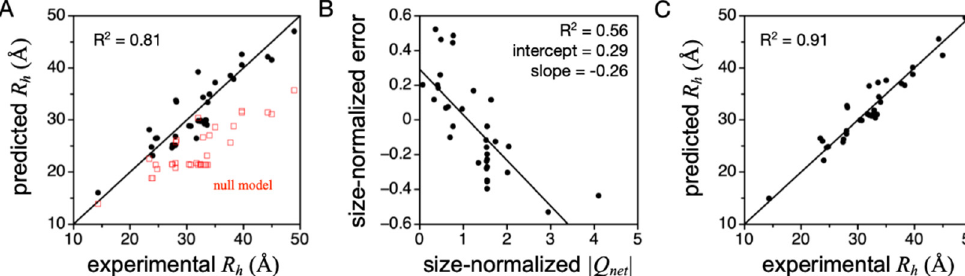
Figure 5. Predicting IDP R h from sequence using experimental PPII propensities. ( A ) R h predicted by Equation (1) compared to experimental R h for 34 IDPs. Predicted values (black circles) were determined from sequence using experimental PPII propensities measured in peptides by Hilser and coworkers (column 4, Table 1). Red squares show R h predictions when using a null model where PPII is not preferentially populated [45]. ( B ) Size-normalized error, (predicted—experimental R h )/ N 0.5 , compared to size-normalized Q net (i.e., | Q net |/ N 0.5 ) for each IDP in panel A. ( C ) Equation (2) predicted R h compared to experimental R h for 34 IDPs. The identity, primary sequence, and experimental R h for the IDPs used to generate data in this Figure are provided in ref. [37]. In each plot, R 2 is the coefficient of determination.